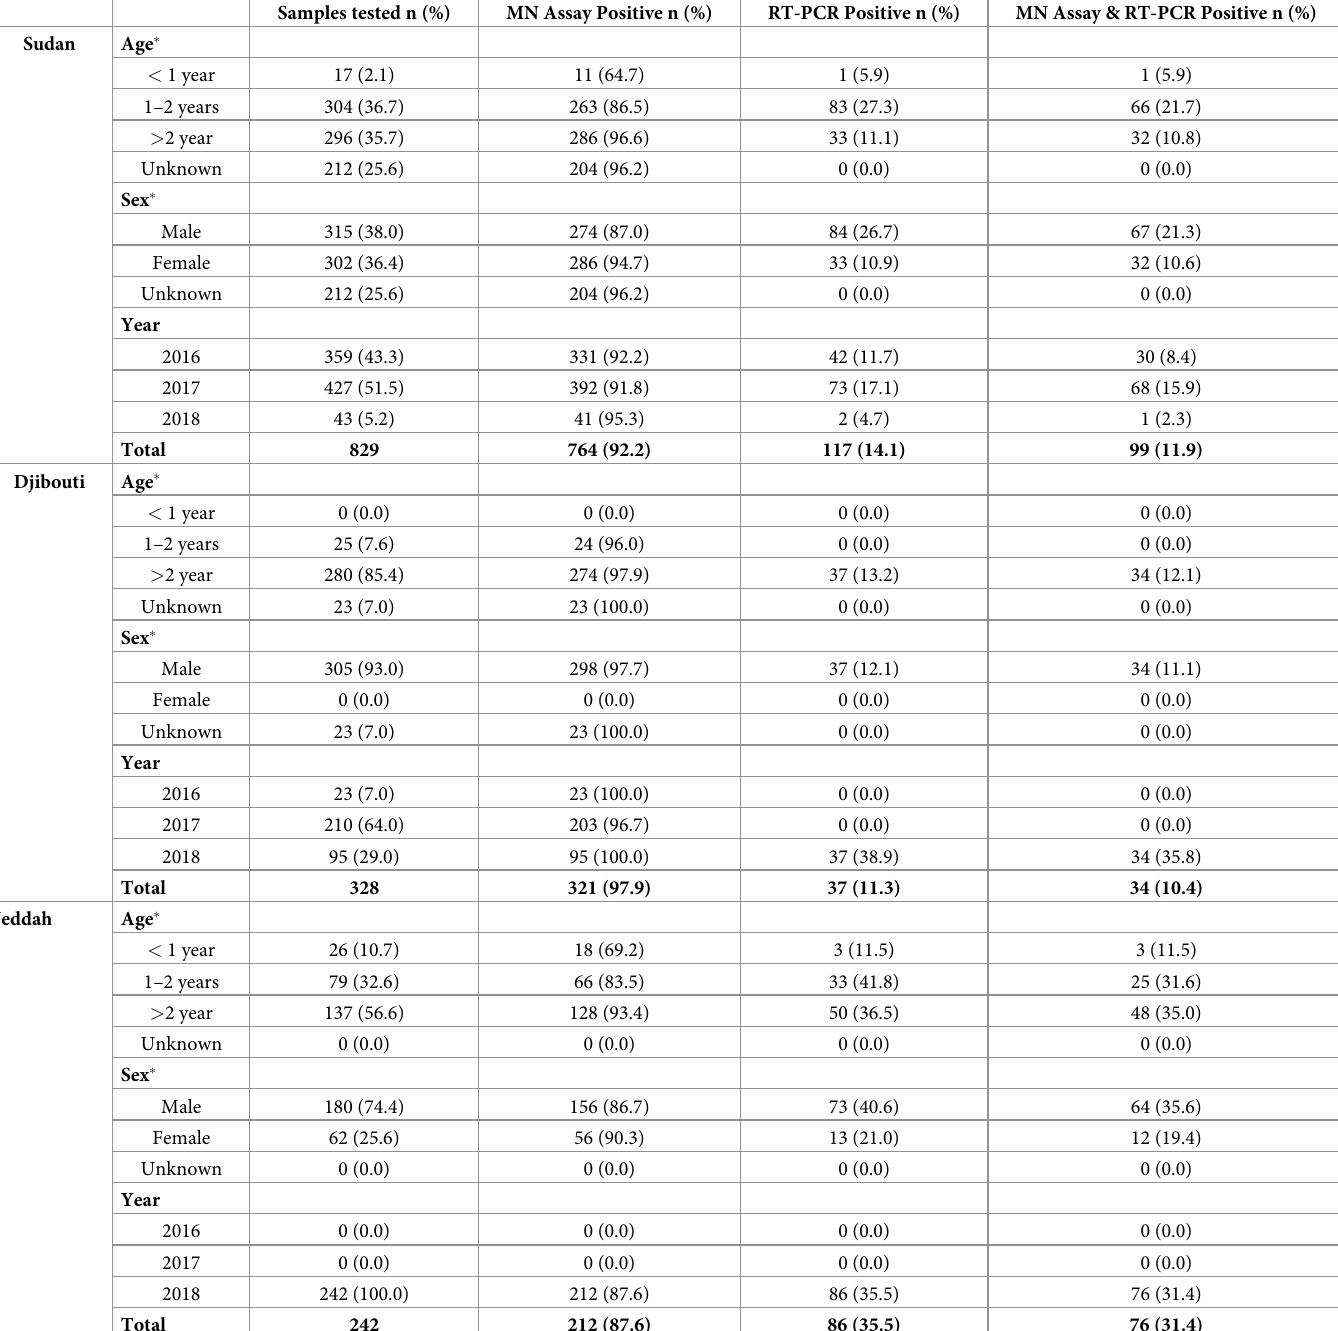
Table 2. Positivity for MERS-CoV nAbs and RNA in camels based on age, sex and year of collection for each individual country. Samples tested n